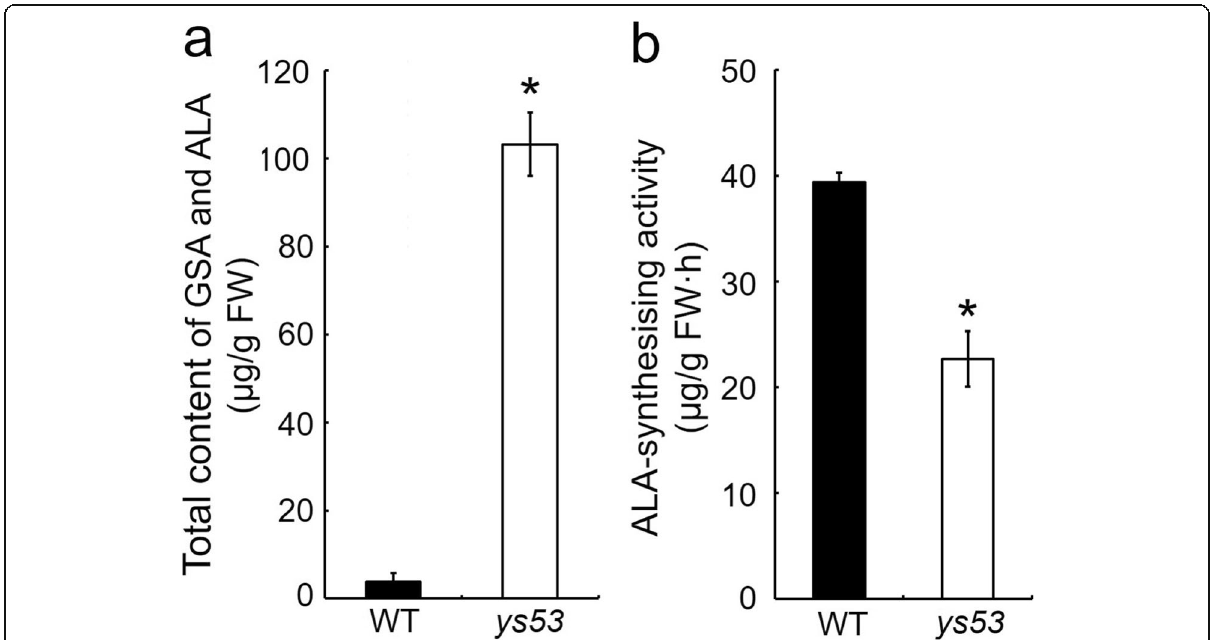
Fig. 4 Determination of GSA and ALA content and ALA-synthesizing activity in ys53 and its wild type. a Total content of GSA and ALA in rice leaves at seedling stage. Leaves were harvested from normal growing seedlings in the paddy field on sunny afternoons, quick freezed in liquid nitrogen and used for determination of total content of GSA and ALA. b ALA-synthesizing activity of rice seedlings. After 1 week of dark culture, the yellow seedlings of ys53 and its wild type were cultured under light condition (100 μ mol m − 2 s − 1 ) for 7 h in LA (levulinic acid) solution, and then the measurement of GSA and ALA was performed. Error bars represent the SDs of three independent experiments. * indicates statistically significant difference between ys53 and its wild type at P <